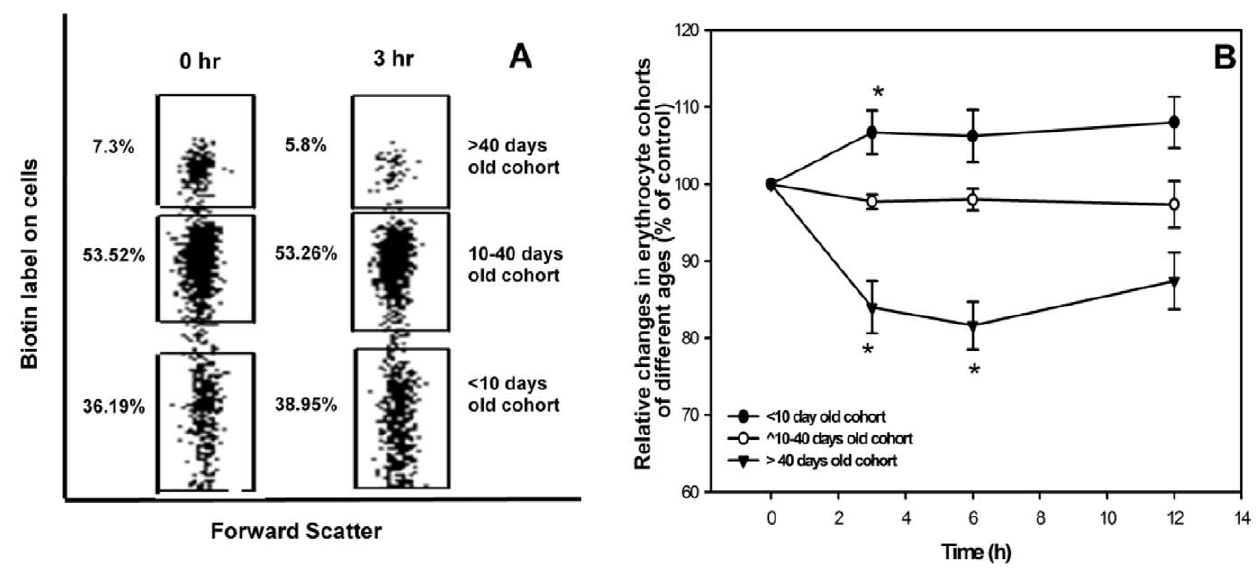
Figure 8. Effect of single intravenous dose of AF-SWCNTs on the proportions of erythrocyte cohorts of different age groups in mouse blood. Mice were prepared by DIB technique as described in materials and methods. AF-SWCNTs (100 m g) was administered i.v. and proportions of erythrocyte cohorts of different ages in blood circulation were monitored. Erythrocyte cohorts were identified by biotin levels on erythrocytes as per the DIB technique [9]. Results of a representative experiment in panel A show the distribution of the three erythrocytes cohorts [Old erythrocytes, (biotin high , age . 40 days, top boxes); intermediate age erythrocytes(biotin low age10–40 days, middle boxes); young erythrocytes (biotin negative age , 10 days, lower boxes)] before and 3h after intravenous administration of AF-SWCNT (100 m g) in 6–8 weeks old Swiss mice. Blood samples were also taken from these mice at different intervals of time and effect of AF-SWCNT administration on the distribution of the three erythrocyte cohorts was assessed at each time points (panel B). Proportion of young, intermediate and old erythrocytes at zero time point were taken as hundred and changes induced by AF-SWCNTs have been depicted as percent of control. Each data point in panel B represents mean 6 SEM of data from swiss mice. *p , 0.05 as compared to control groups by ANOVA.